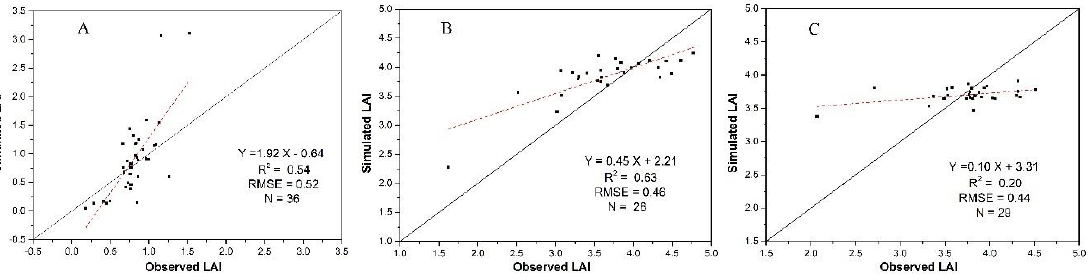
Figure 8. The LAI estimation accuracies using assimilation method ( A ) 30 June, ( B ) 29 July, ( C ) 25 August.